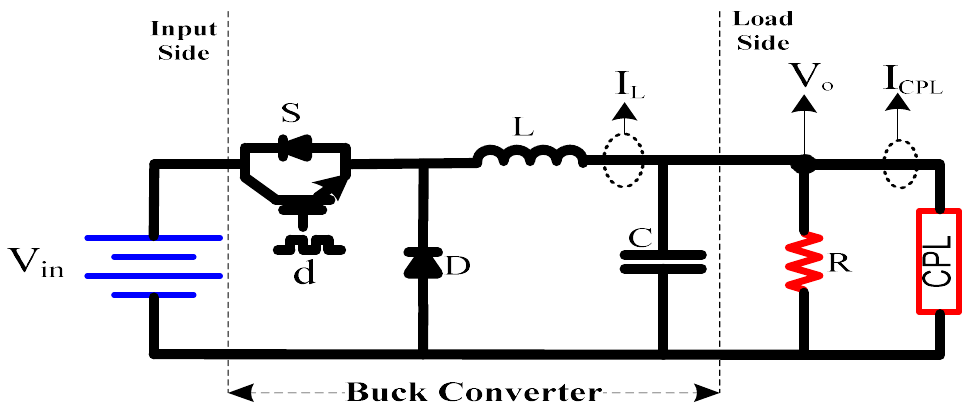
Figure 2. The typical circuit for a DC/DC buck converter with CPL.